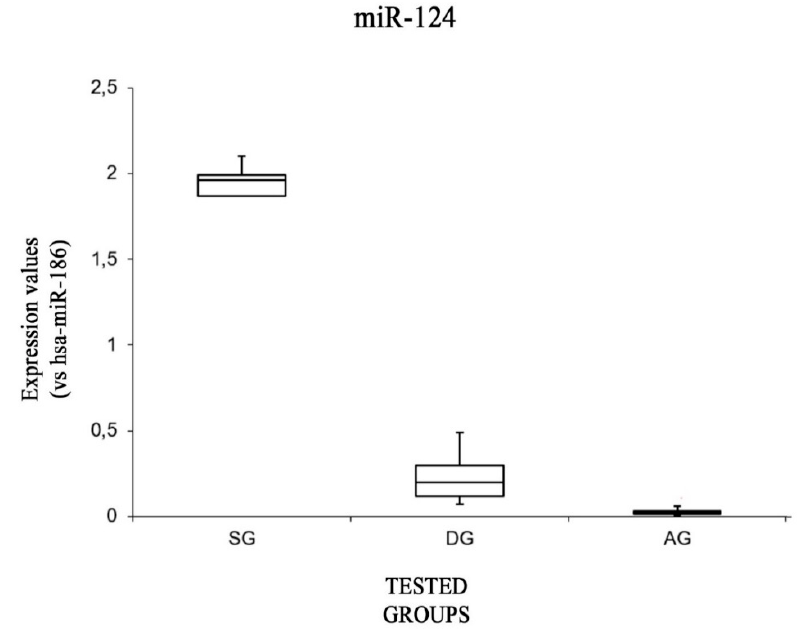
Figure 5. Box plot analysis showing the expression levels of miR-124 (endogenous control miR-186) in each group.